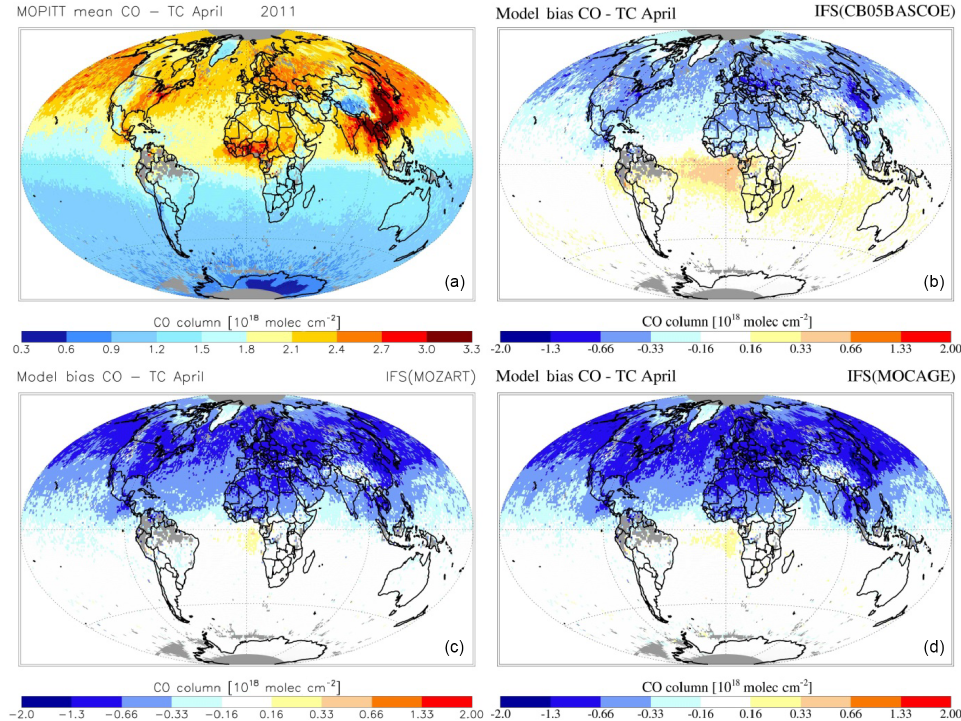
Figure 8. MOPITT CO total column retrieval for April 2011 (a) and simulated by IFS(CBA) (b) , IFS(MOZ) (c) and IFS(MOC) (d) .